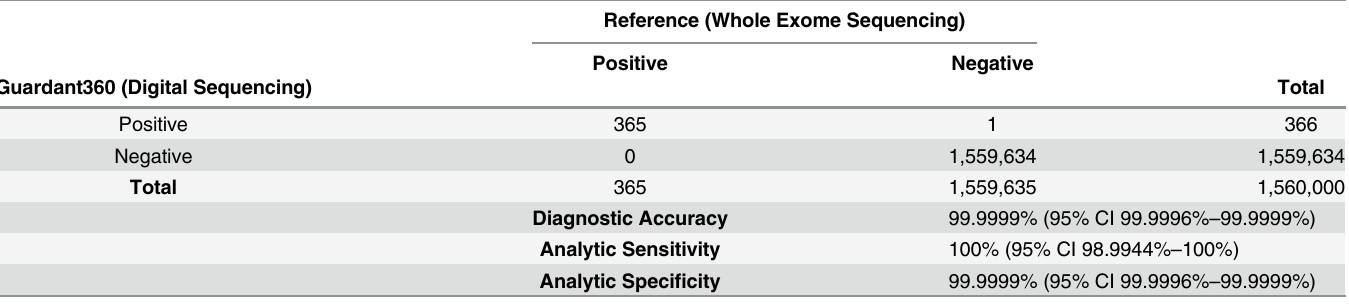
Table 1. Two by two table comparison of the diagnostic performance of digital sequencing to whole exome sequencing of the 54-gene panel. Twenty samples at 78 kpbs per sample were sequenced with a single apparent false positive and no false negatives, resulting in 100% analytic sensitivity (at roughly 2.5% SNV mutant allele frequencies) and near-perfect 99.9999%